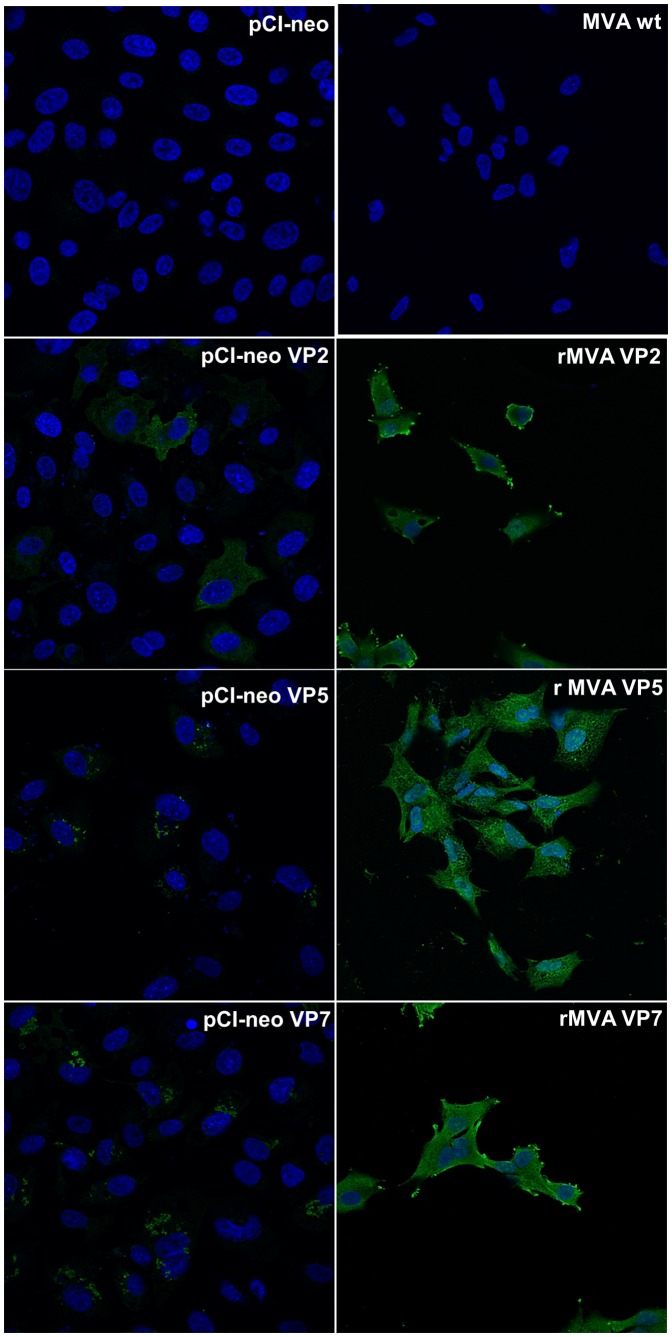
Expression of recombinant BTV proteins from rMVAs and pCi-neo plasmids by immunofluorescence.CEF cells infected with rMVA-VP2, VP5 or VP7, or Vero cells transfected with pCI-neo VP2, VP5 or VP7 were analysis by immunofluorescence assay. Empty MVA and pCI-neo were used as negative controls. Fluorescence was observed on cells using a sheep serum anti BTV-8 followed by Alexa Fluor 488-conjugated donkey anti-sheep IgG. Nuclei were staining with DAPI. BTV protein expression from pCI-neo plasmids or rMVAs encoding VP2, VP5 and VP7 proteins was observed by confocal microscopy.